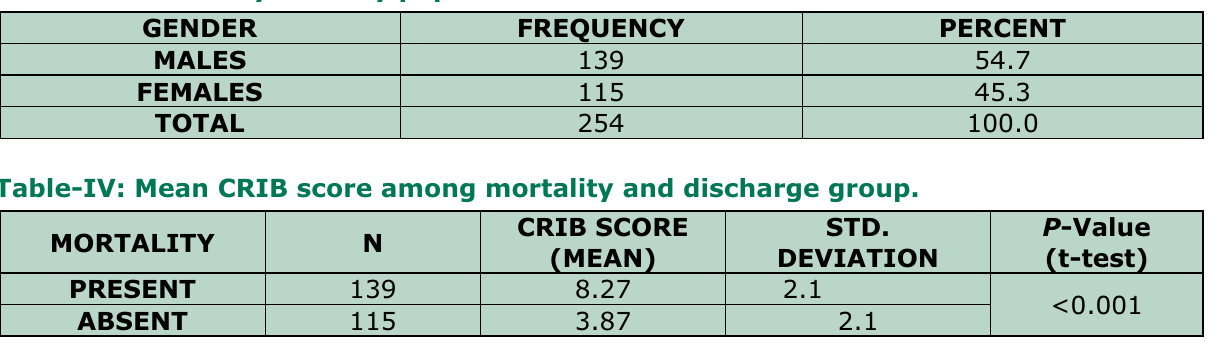
Table-III: M  ortality in study population.